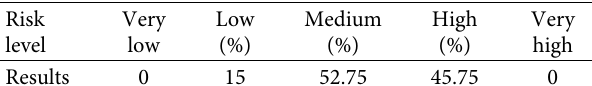
Table 6: Membership probability of assessment results.